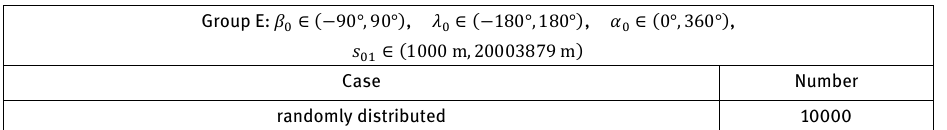
Table 9: Description of the geodesics in the Group E